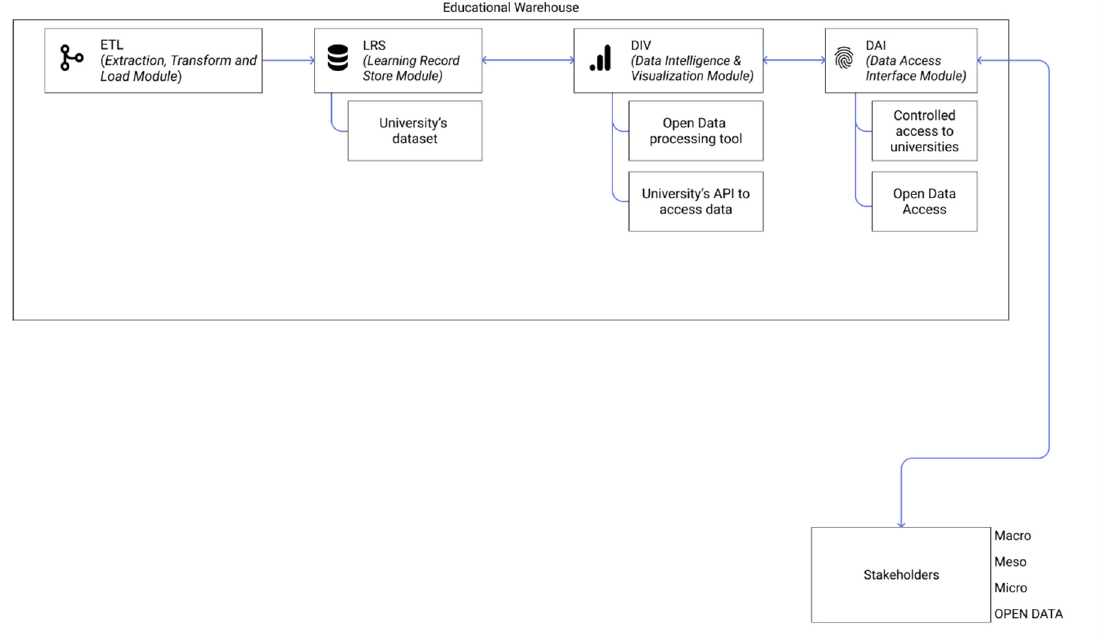
Figure 4. The educational warehouse architecture proposal for research entities working with open data: the modules represented offer the ability to progress towards the study’s objective.